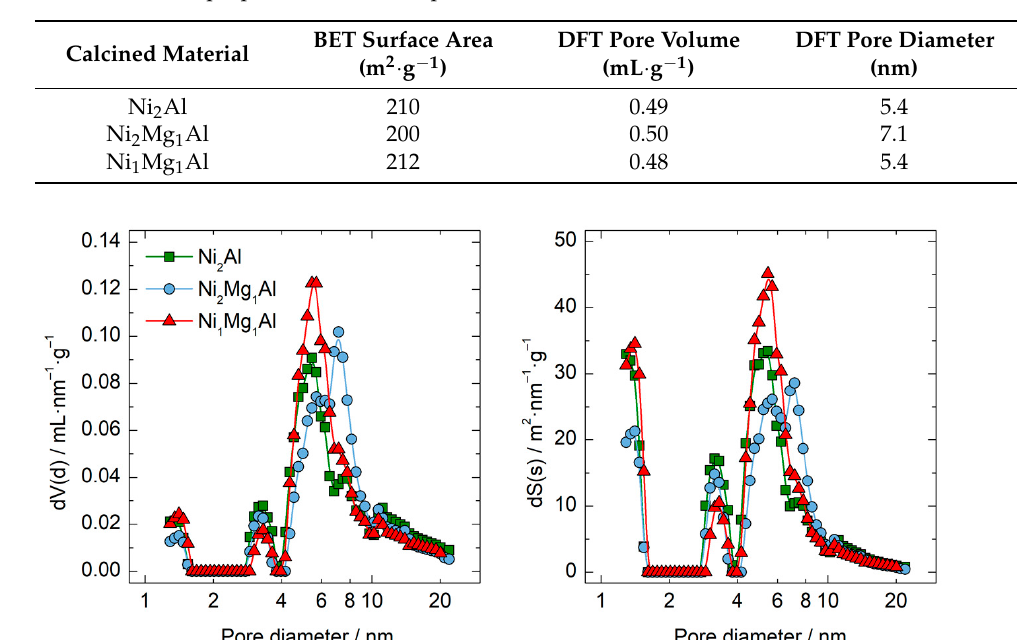
Figure 1. N 2 physisorption isotherms of the LDH precursors calcined at 400 °C for 4 h. The red symbols are the adsorption branch, and the black symbols are the desorption branch of the isotherm. Table 2. Textural properties of the LDH precursors calcined at 400 ◦ C for 4 h.